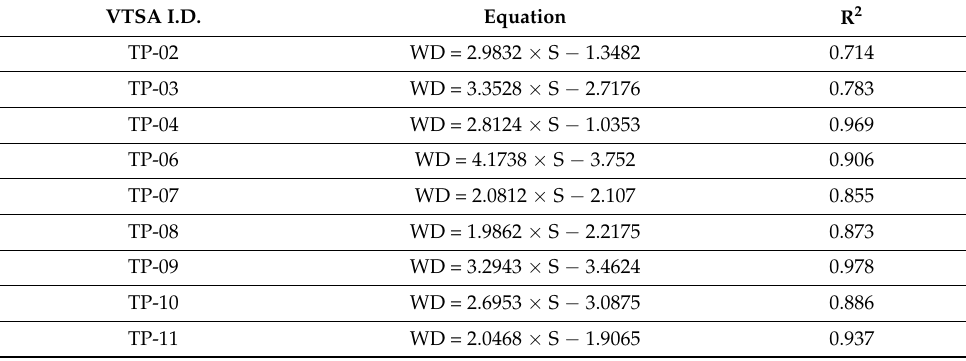
Table 5. List of equations and R 2 values for each VTSA generated from water level rating curves. S is the river stage observed at USGS 06191500 and WD is the depth of water of the riverbed at each